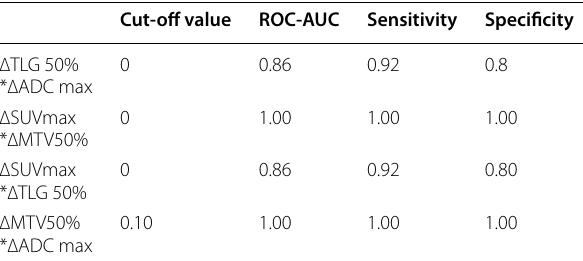
Table 5 Combination of PET/MRI features as well as the ADC allows differentiation between chemotherapy responders and non-responders with high sensitivity and specificity